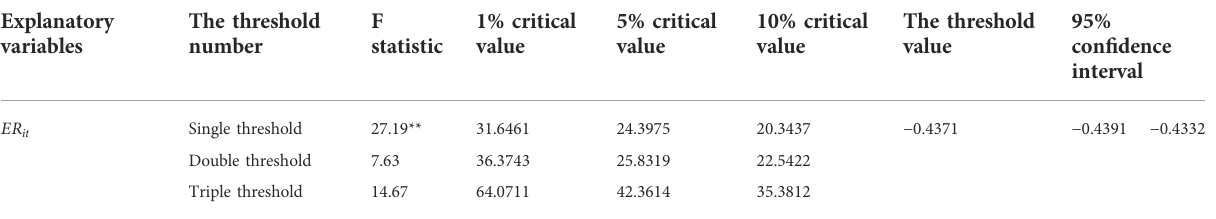
TABLE 8 Threshold test results.